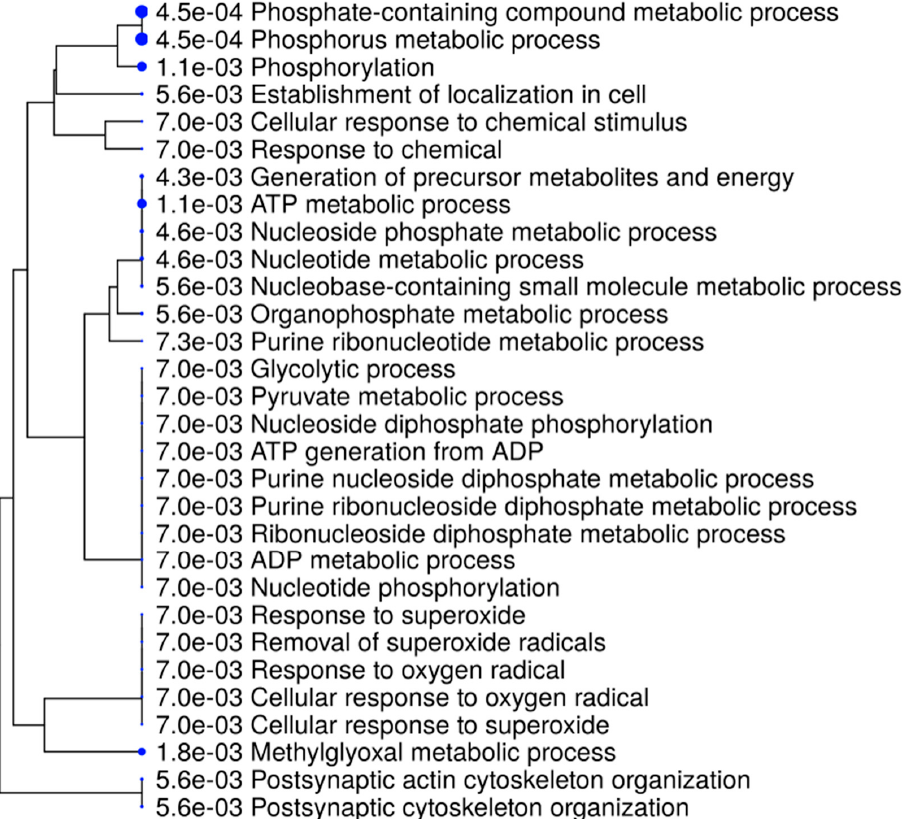
Figure 3. Hierarchical clustering tree summarizing the top 30 most significantly enriched GO terms that were identified in rat hippocampus. The analyzed dataset was consisted of 20 significantly differentially expressed hippocampal proteins.